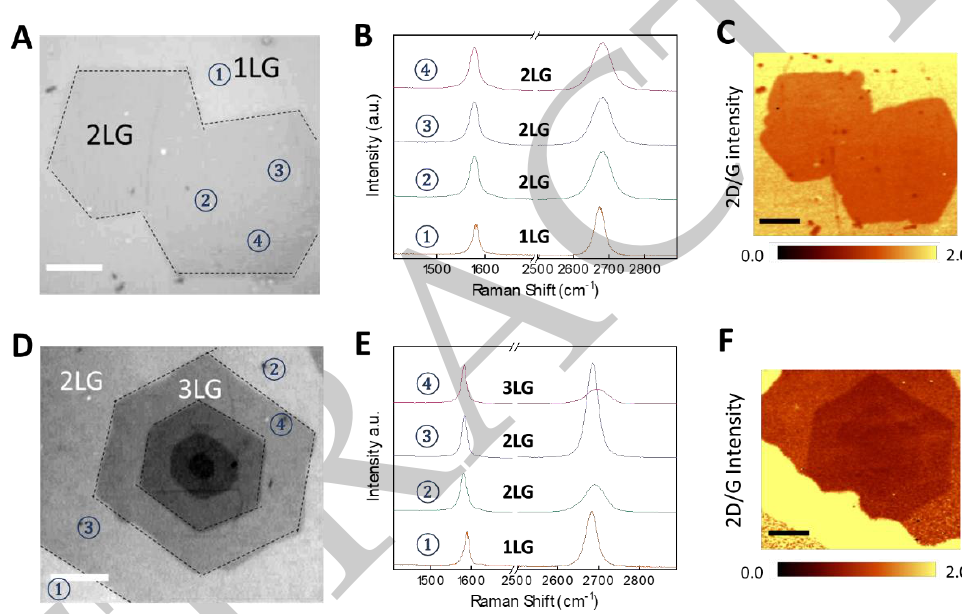
Figure 3. Raman analysis of graphene samples: ( A ) and ( D ) Optical images of graphene samples grown on treated and bare Cu, respectively; ( B ) and ( E ) the corresponding Raman spectra taken at different positions as indicated; ( C ) and ( F ) the corresponding Raman maps of I 2D /I G ratios. Laser spot size was about 500 nm, and the mapping step size was 200 nm. All scale bars are 5 μm.